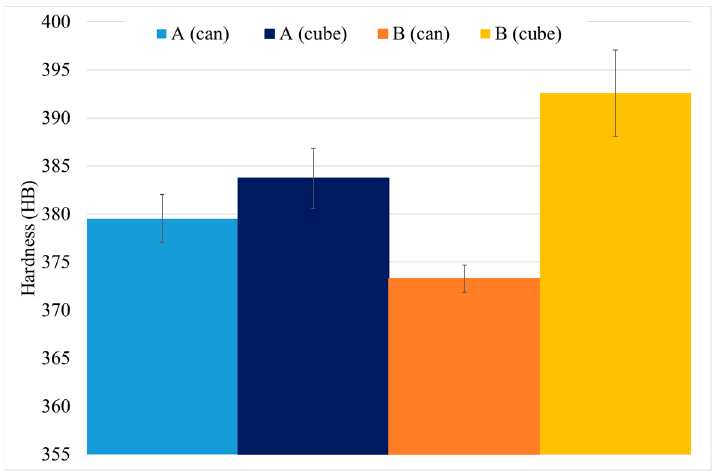
Figure 15. Hardness measurements of HT samples.